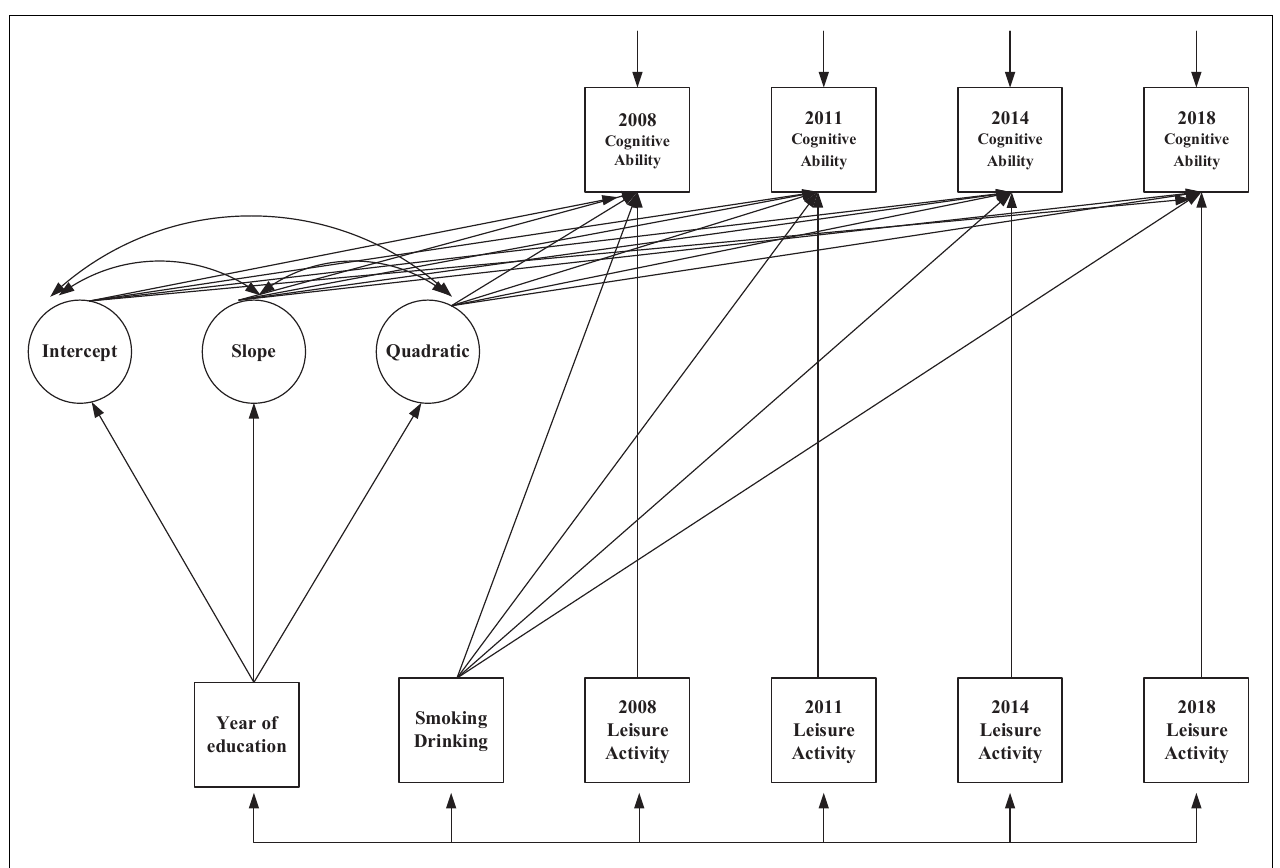
FIGURE 7 | Impact of leisure activities on the change track of cognitive ability.